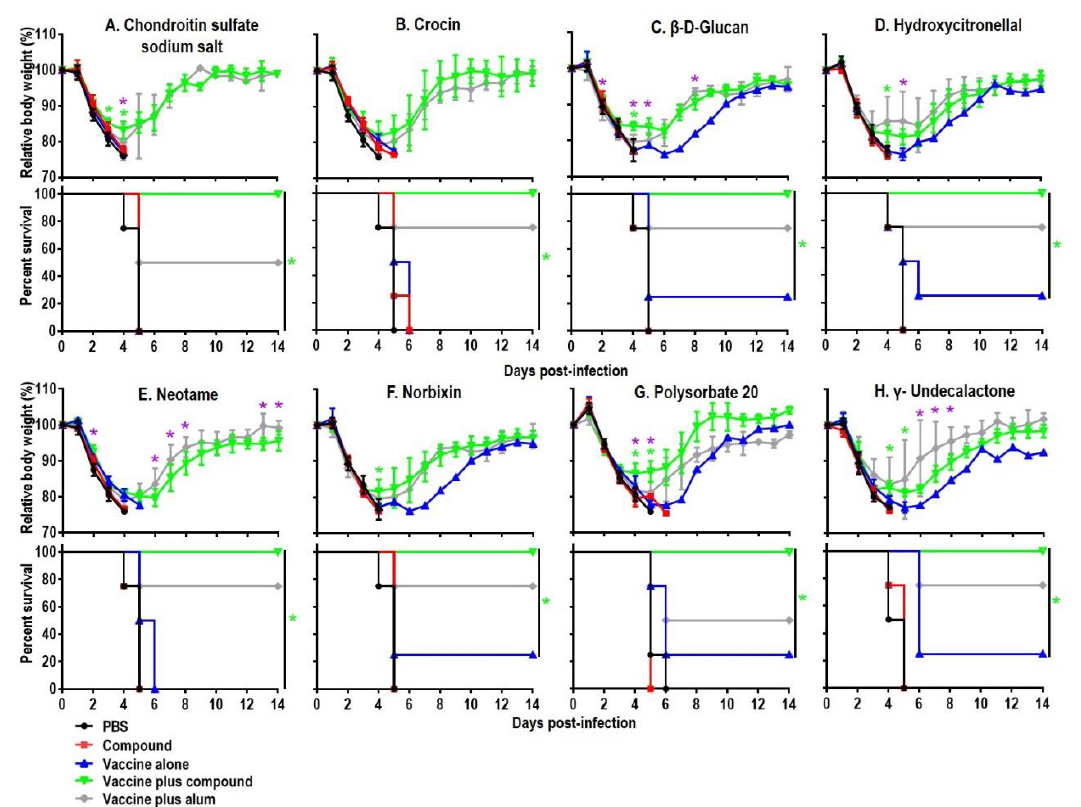
Figure 2. Body weight changes and survival rates of immunized mice after lethal challenge. Six-week-old BALB/c mice were mock-immunized with phosphate-buffered saline (PBS) or compounds only, or they were immunized with the HA vaccine alone or the compound-adjuvanted HA vaccine twice with a two-week interval. Mice were intranasally challenged with 10 MLD 50 of MA-CA04 virus three weeks after the second immunization. Body weight and survival were monitored for 14 days. The body weight data shown are means and standard deviations ( n = 4). Green asterisks indicate a significant difference between the vaccine alone and the vaccine plus compound groups (vaccine plus compound versus vaccine alone); purple asterisks indicate a significant difference between the vaccine plus alum and the vaccine plus compound groups (vaccine plus alum versus vaccine plus compound); * p < 0.05.